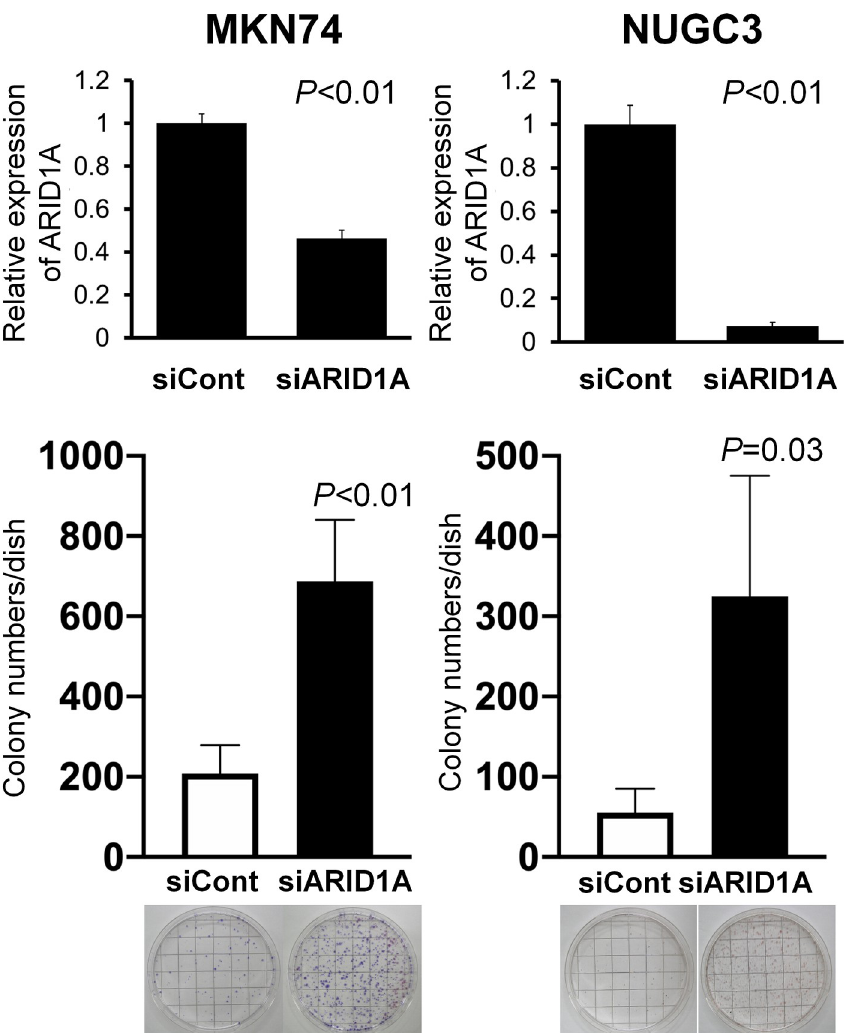
neomycin-resistant gene. After selection with G418, resistant colonies were stained with hematoxylin. Note a three- and six-fold increase in G418-resistant colonies in ARID1A -knockdown MKN74 and NUGC3 cells, respectively, compared with the cells treated with control